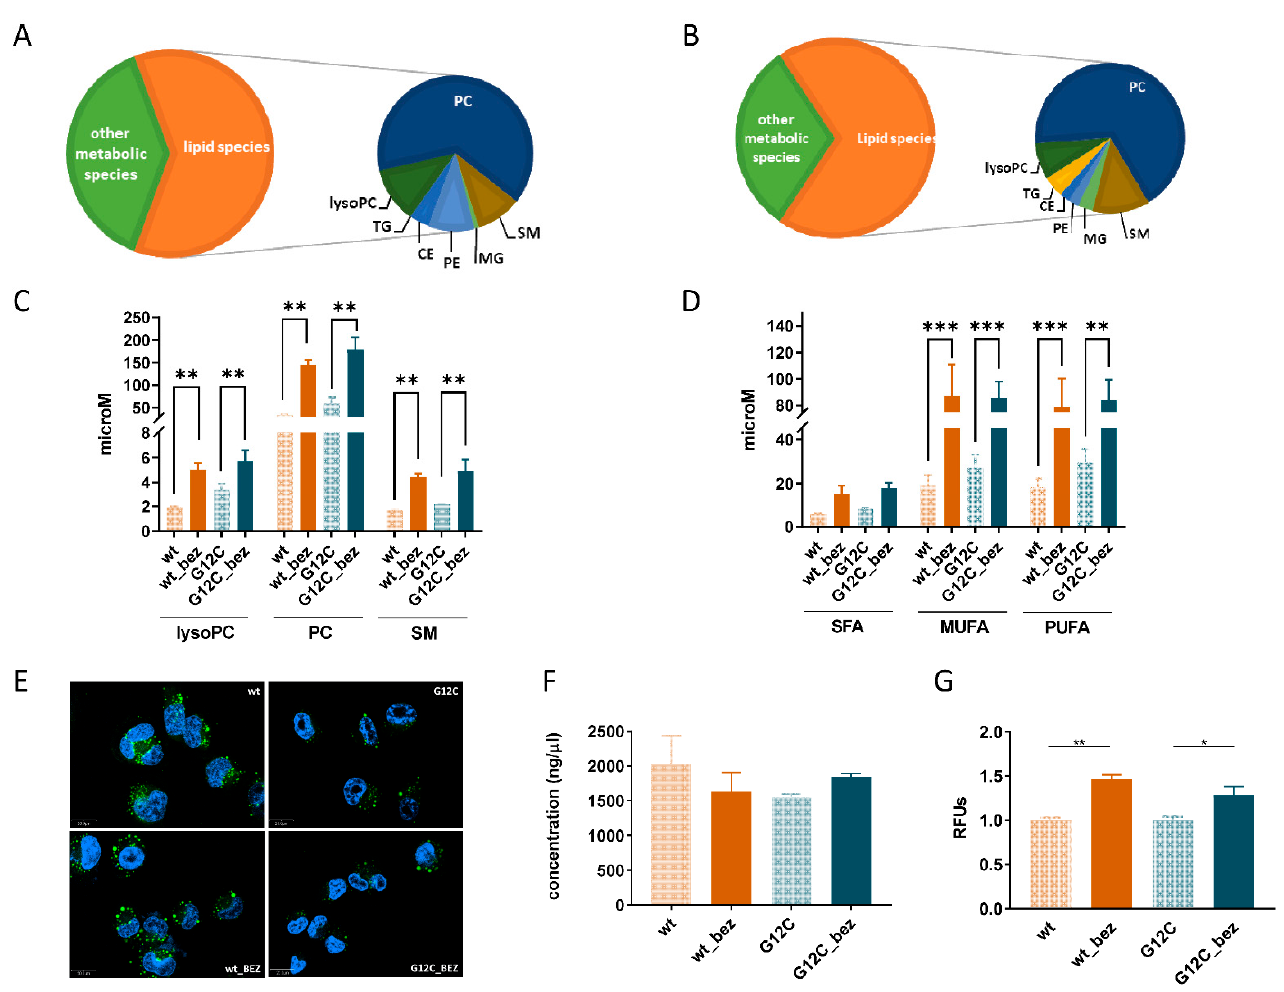
Figure 2. ( A ) Pie chart summarizing the metabolic class distribution of the statistically significant metabolites between the wt and wt_bez clones. ( B ) Pie chart summarizing the metabolic class dis- tribution of the statistically significant metabolites between G12C and G12C_bez clones. ( C ) Sum of intracellular concentrations of lysophosphatidylcholines (lysoPC), phosphatidylcholines (PC), and sphingomyelins (SM) in wt, wt_bez, G12C, and G12C_bez clones. ** indicates statistically significant differences with p < 0.01 (two-way ANOVA and Tukey Kramer post-hoc test). ( D ) Sum and distri- bution of intracellular concentrations of saturated (SFA), monounsaturated (MUFA), and polyun- saturated (PUFA) lipid species. ** and *** indicate statistically significant differences with p < 0.01 and p < 0.001, respectively (two-way ANOVA and Tukey Kramer post-hoc test). ( E ) Representative images of lipid droplets detected by Nile Red fluorescent dye (green) in all the clones. DAPI (blue) was used to counterstain nuclei. The scale bar is 20.0 µM. ( F ) Intracellular concentration of free cho- lesterol. ( G ) Membrane fluidity expressed as relative fluorescence units (RFUs) of the ratio between PDA dimer and monomers, detected by a membrane fluidity kit (Abcam, see Methods section). * and ** indicate statistically significant differences with p < 0.05 and p < 0.01, respectively (one-way ANOVA and Bonferroni post-hoc test). LysoPC, Lysophosphatidylcholine, PC, Phosphatidylcho- line, PE, lysophosphatidylethanolamine, CE, Ceramide, SM, Sphingomyelin, MG, monoacylglycer- ide, and TG, Triglyceride.